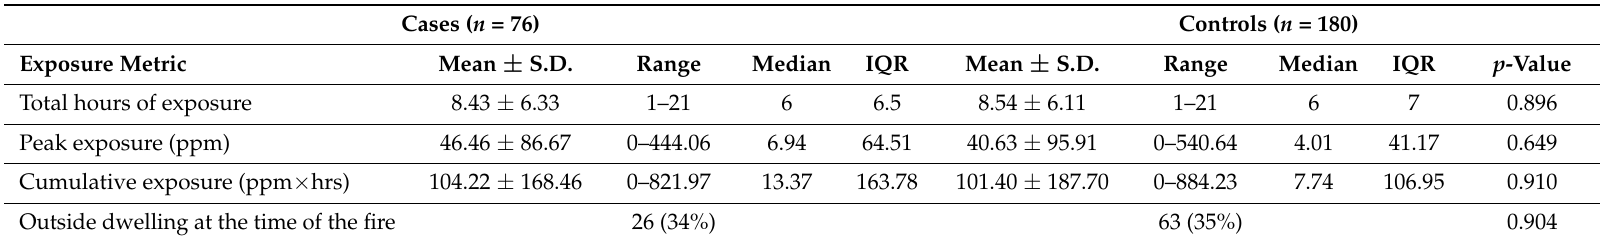
t -test for continuous variables, chi-square test for categorical variables. t-test for continuous variables, chi-square test for categorical variables.